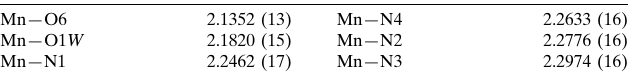
Selected bond lengths (A˚ ).